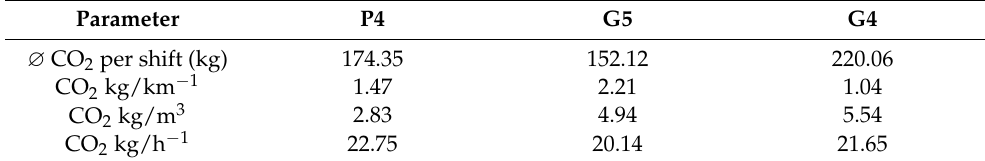
Table 7. Carbon dioxide production of the Scania P450 (P4), G500 (G5), and G440 (G4) logging trucks.